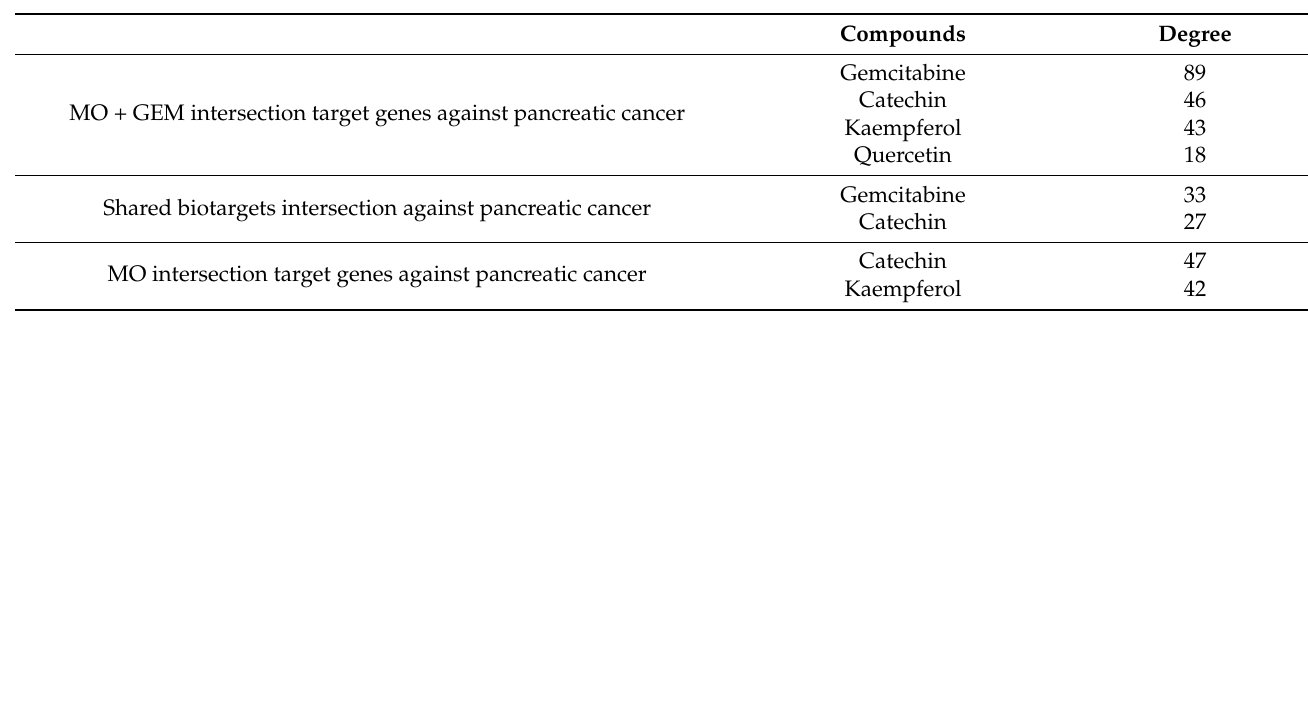
Figure 5. The Kyoto Encyclopedia of Genes and Genomes (KEGG) pathway analysis of MO, and its combination with GEM against pancreatic cancer. ( a ) The bar chart represents the top 10 KEGG pathway analysis of MO + GEM intersection target genes against pancreatic cancer. ( b ) The bar chart represents the top 11 KEGG pathway analysis of shared biotargets intersection against pancreatic cancer. ( c ) The bar chart represents the top 10 KEGG pathway analysis of MO intersection target genes against pancreatic cancer. Table 3. Hub compounds in compound-target network based on the degree